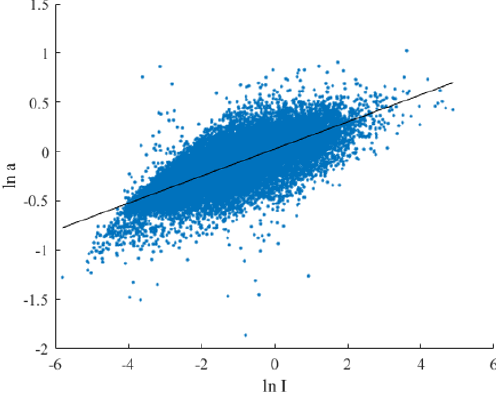
Figure 6. Evaluation of Eq. (4) for precipitation intensities 0.1058, 1.2708, 4.9865 and 10.2624mmh − 1 .